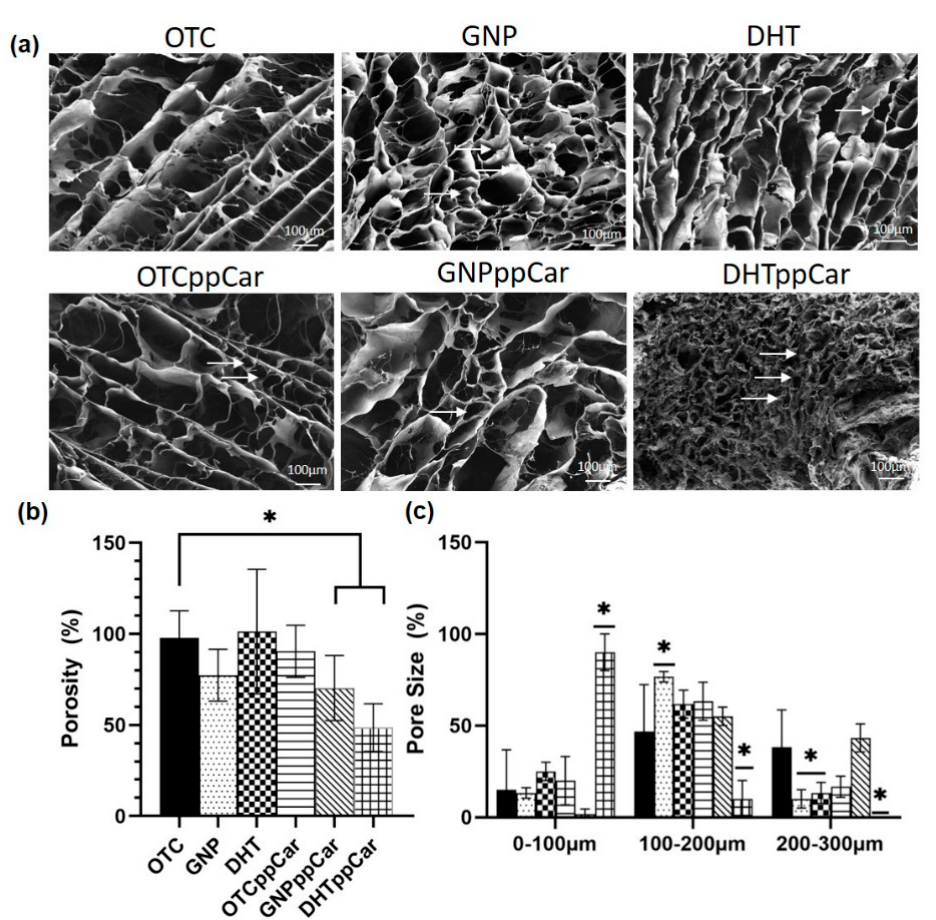
Figure 6. ( a ) The heterogeneous microstructure of OTC-I sponges showing interconnective pores before and after crosslinking with GNP and DHT and ppCar. DHTppCar had most shrinkage after crosslinking and reduced porosity after carvone deposition; ( b ) liquid dispersion assay conveys SEM data in which all scaffolds except for DHTppCar were >50%; ( c ) pore size distribution of OTC-I scaffolds indicated acceptable pore size range from 100 to 200 µ m except for the case of DHTppCar. * p ≤ 0.05 indicates significant differences in the fabricated materials.